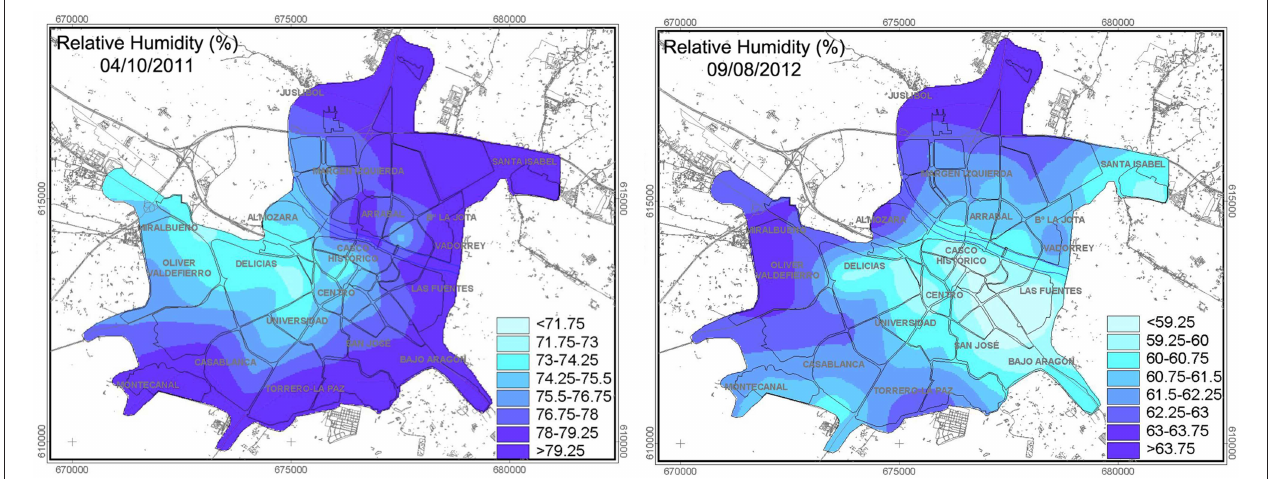
FIGURE 3 | Examples of standardized UHI maps in Zaragoza: October 4th 2011 and August 9th 2012.